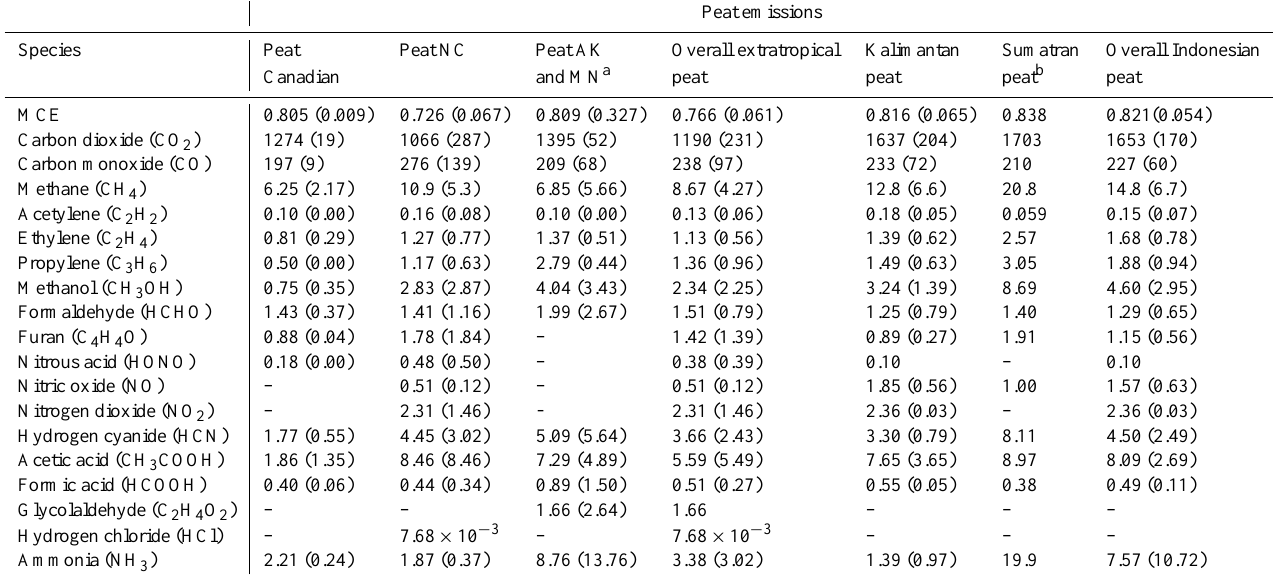
Table 3. Comparison of emission factors (gkg − 1 ) for three laboratory peat studies: Yokelson et al. (1997), Christian et al. (2003), and FLAME-4. The average and one standard deviation are shown for each peat type during the study, and an overall regional EF is shown for extratropical and Indonesian peat. Values in parentheses are one standard deviation.